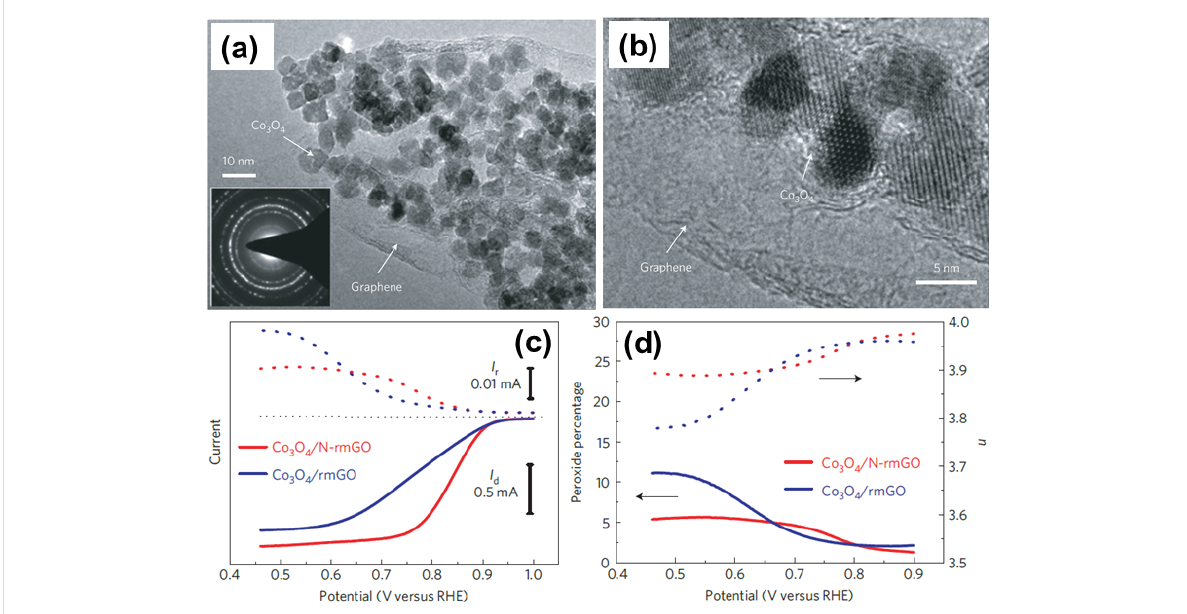
Figure 6: (a) Low magnification and (b) high magnification TEM images of Co 3 O 4 /N-doped reduced mildly oxidised graphene oxide (N-rmGO) hybrid. (c) Assessment of peroxide percentage in ORR catalysed by hybrid catalysts was made from rotating ring-disk electrode voltammograms recorded with Co 3 O 4 /rmGO hybrids (loading ≈ 0.1 mg·cm − 2 ) and Co 3 O 4 /N-rmGO hybrids (loading ≈ 0.1 mg·cm − 2 ) in O 2 -saturated 0.1 M KOH at 1,600 r.p.m. Disk current ( I d ) (solid line) is shown on the lower half and ring current ( I r ) (dotted line) is shown on the upper half of the graph. The disk potential was scanned at 5 mV·s − 1 and the ring potential was constant at 1.5 V versus reversible hydrogen electrode (RHE). (d) Percentage of peroxide (solid line) and the electron transfer number ( n ) (dotted line) of Co 3 O 4 /rmGO and Co 3 O 4 /N-rmGO hybrids at various potentials, inferred from the corresponding RRDE data in (c). Reprinted by permission from [170], copyright 2011 Macmillan Publisher